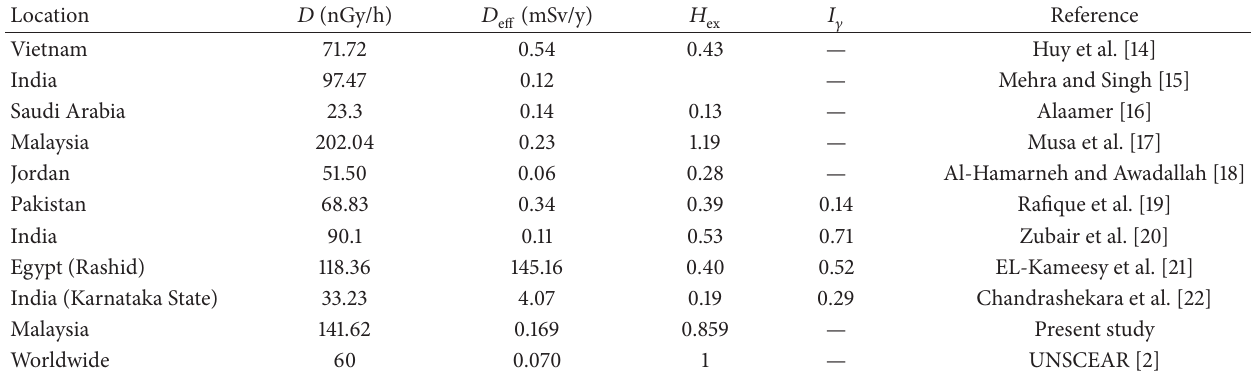
Table 6: Average hazard indices of the primordial radionuclides in the worldwide agricultural soils.